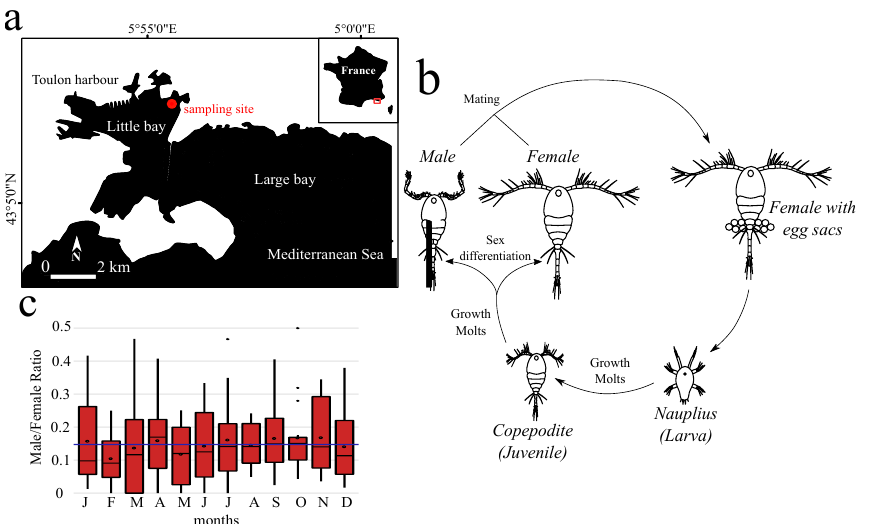
Figure 1. Life cycle and sex ratio of the copepod Oithona nana in the Toulon Little Bay. ( a ) Map of the sampling site in the Toulon Little Bay created with the “maps” R package 3.3.0 and modified with Inkscape 0.92.4. ( b ) The life cycle of O. nana . ( c ) Sex ratio of O. nana from 2002 to 2017 in the Toulon Little Bay. Black circles represent the monthly mean, the blue line represents the 15-year mean